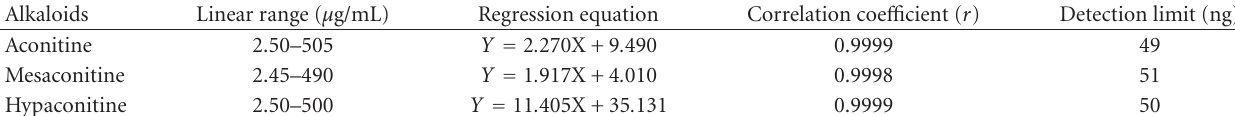
Table 2: The regression equation, linear range, correlation coe ffi cient ( r ), and limit of detection obtained from the established HPLC method for the assay of aconitine (A), mesaconitine (MA), and hypaconitine (HA).